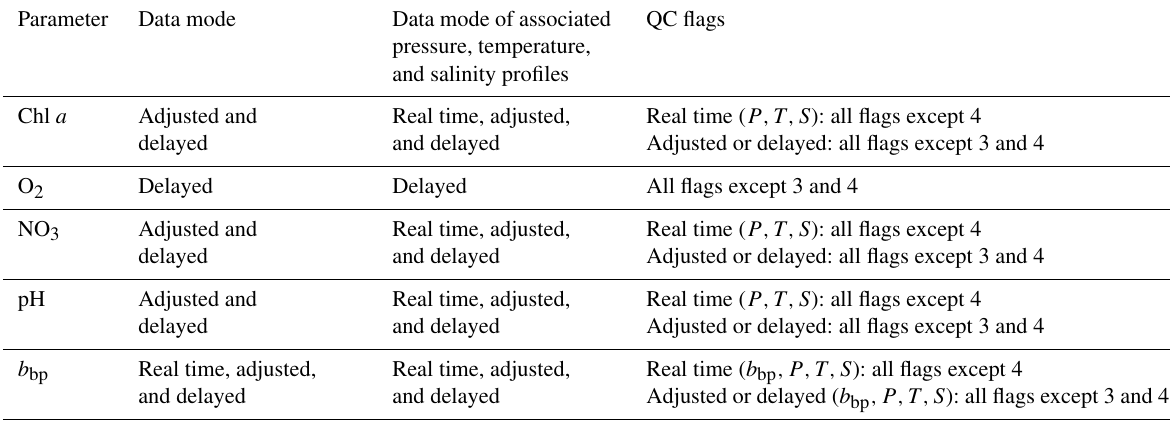
Table 1. Data mode and QC flags of the BGC-Argo observations used in this study. In the Argo data system, the data are available in three data modes: “real time”, “adjusted”, and “delayed”. See Sect. 2.1 for a brief description of each data mode. The flags “3” and “4” refer to “potentially bad data” and “bad data”, respectively. The reader is referred to Bittig et al. (2019) for a more detailed description of the Argo data modes and